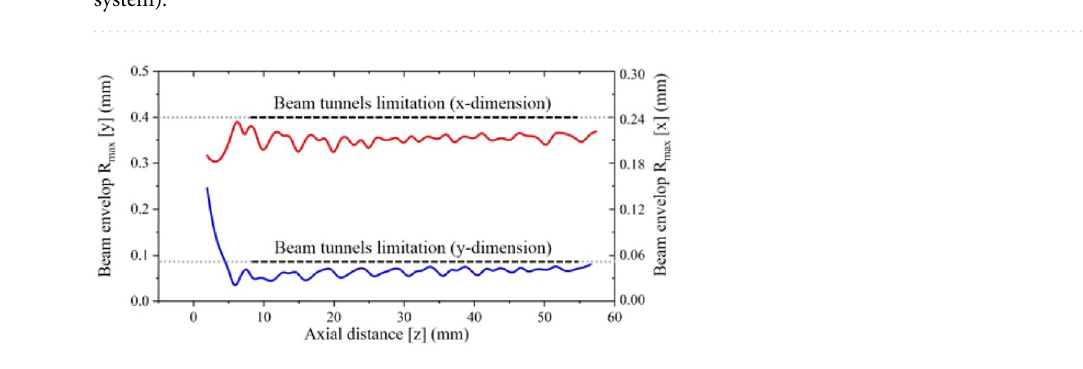
Figure 17. Envelop of the double pencil beams under the uniform magnetic focusing